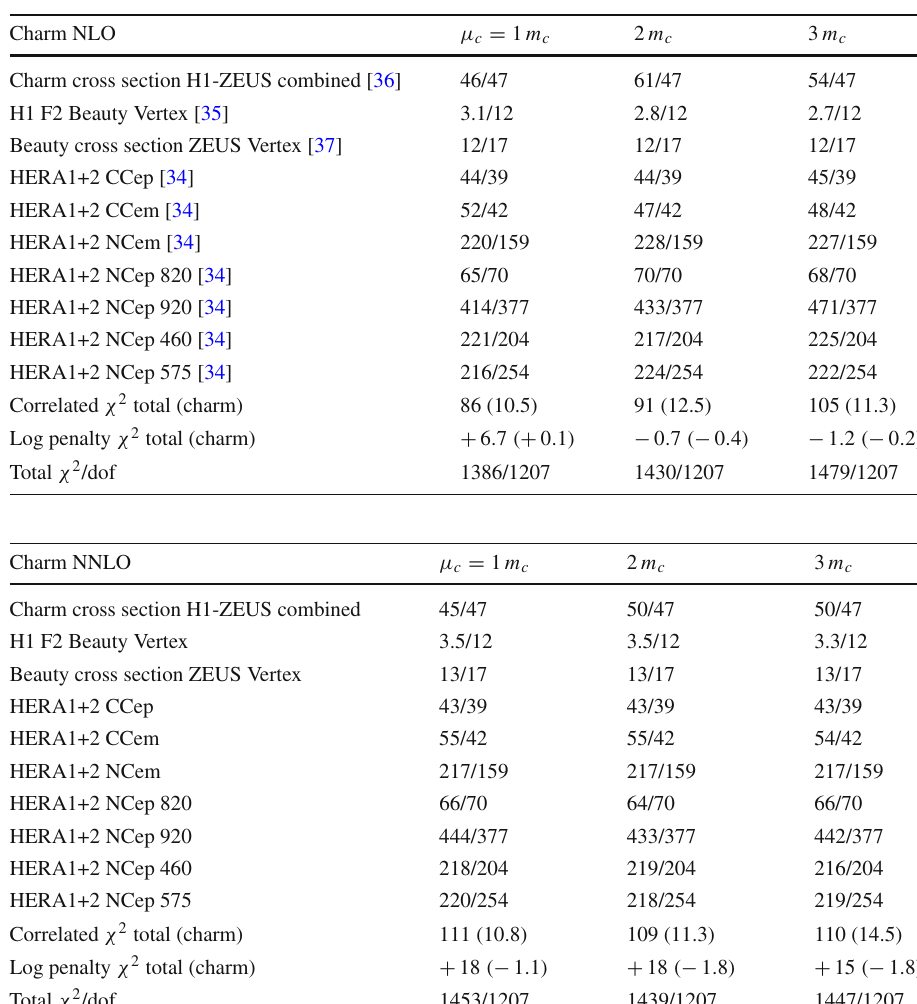
Table 1 The χ 2 values at NLO for individual data sets for a selection of the charm matching scales μ c . The contribution of the charm data contained in the “Correlated χ 2 ” and in the “Log